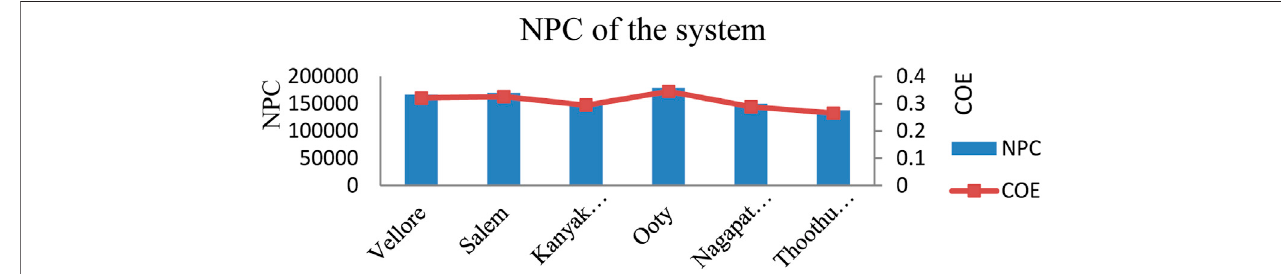
FIGURE 13 | System NPC and COE.